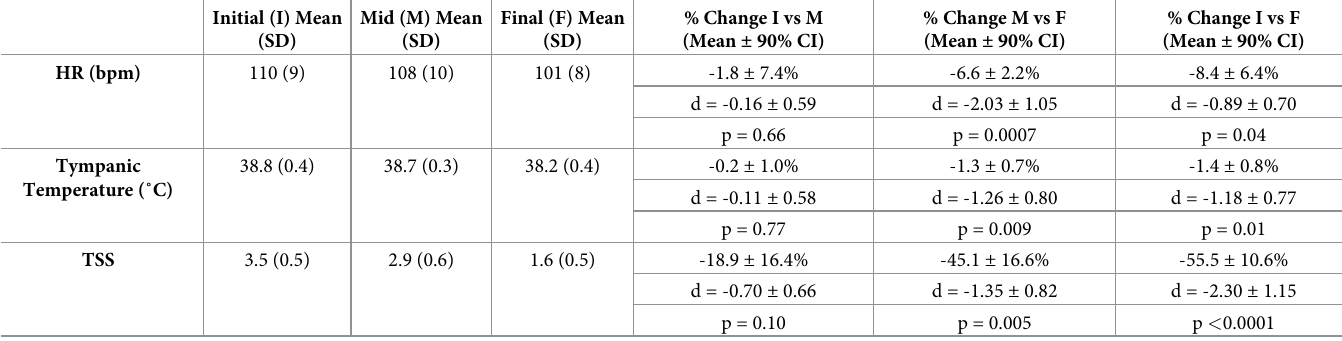
Table 1. Physiological and perceptual data from Initial, Mid and Final hot water immersion sessions in HEAT. Initial (I) Mean